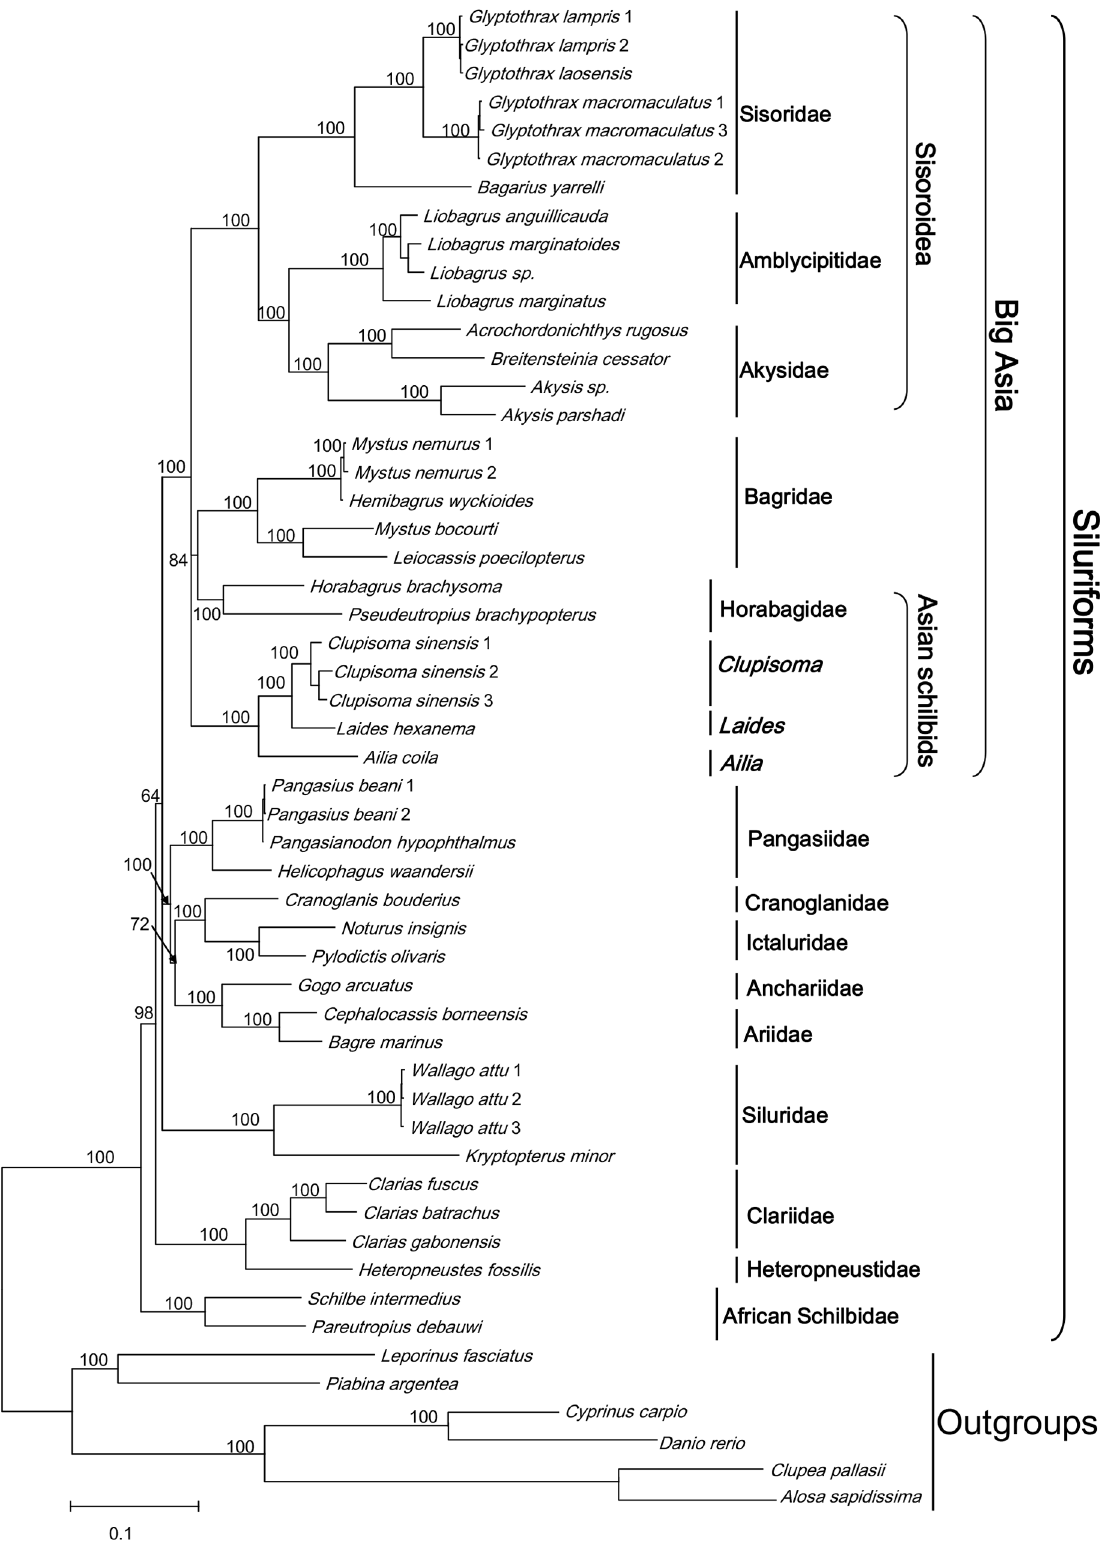
Fig 3. Phylogenetic relationships of the Siluriformes based on a Bayesian inference analysis of concatenated mtDNA genes and partitioned nuclear genes. Nodal support values are Bayesian posterior probabilities. The names Sisoroidea and “ Big Asia ” are after Sullivan et al . (2006) [8]. doi:10.1371/journal.pone.0145675.g003 PLOS ONE | DOI:10.1371/journal.pone.0145675 January 11,